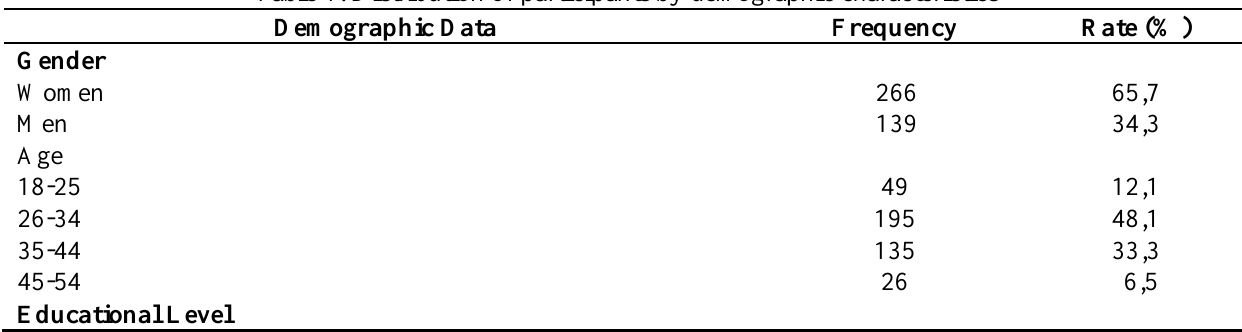
Table 1. Distribution of participants by demographic